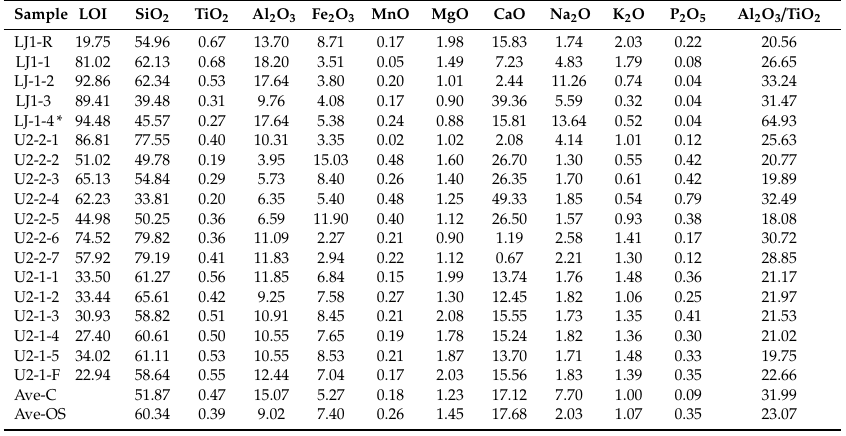
Table 2. Concentrations of major-element oxides (%), loss on ignition (LOI, %) and Al 2 O 3 / TiO 2 in the Liangjia C1, OS2, the roof and floor samples (on ash basis), determined by XRF analysis. Sample